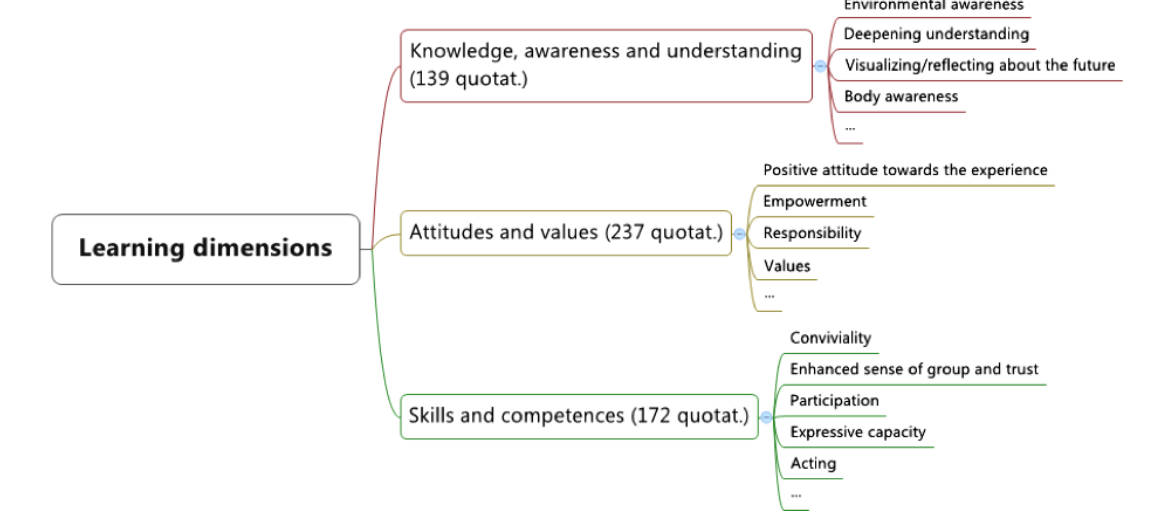
Fig. 3 . Open evaluation analysis with Atlas.ti 6.2: learning dimensions, total number of associated quotations, and most cited emerging